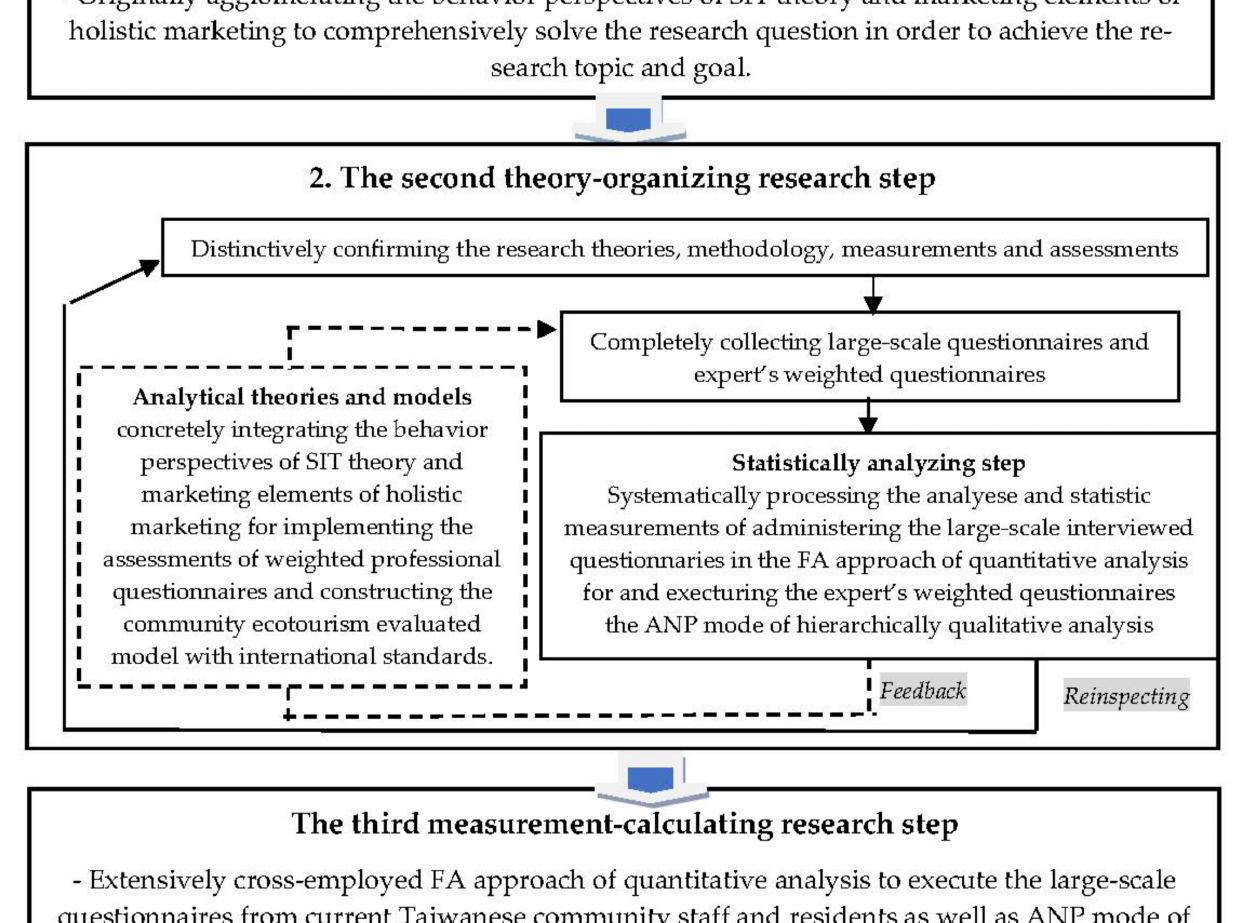
Figure 2. Research design and